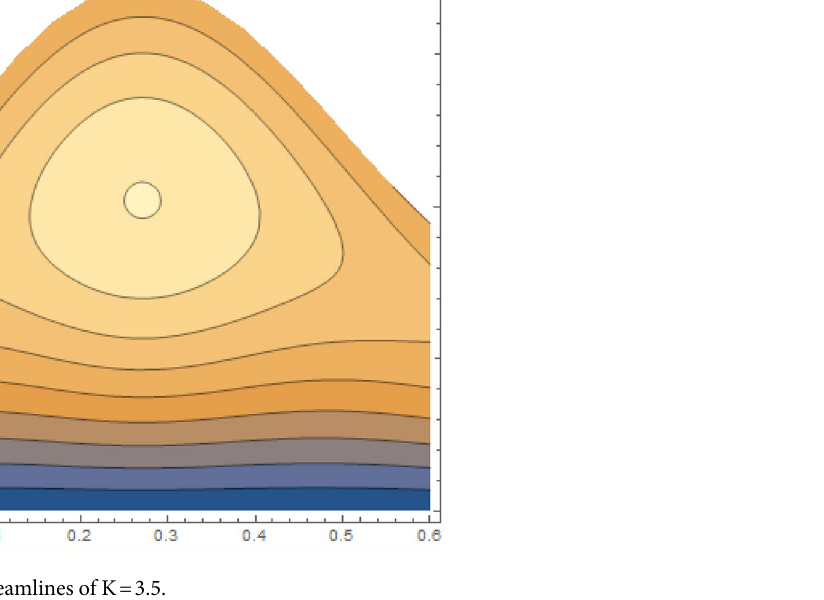
Figure 23. Streamlines of K =